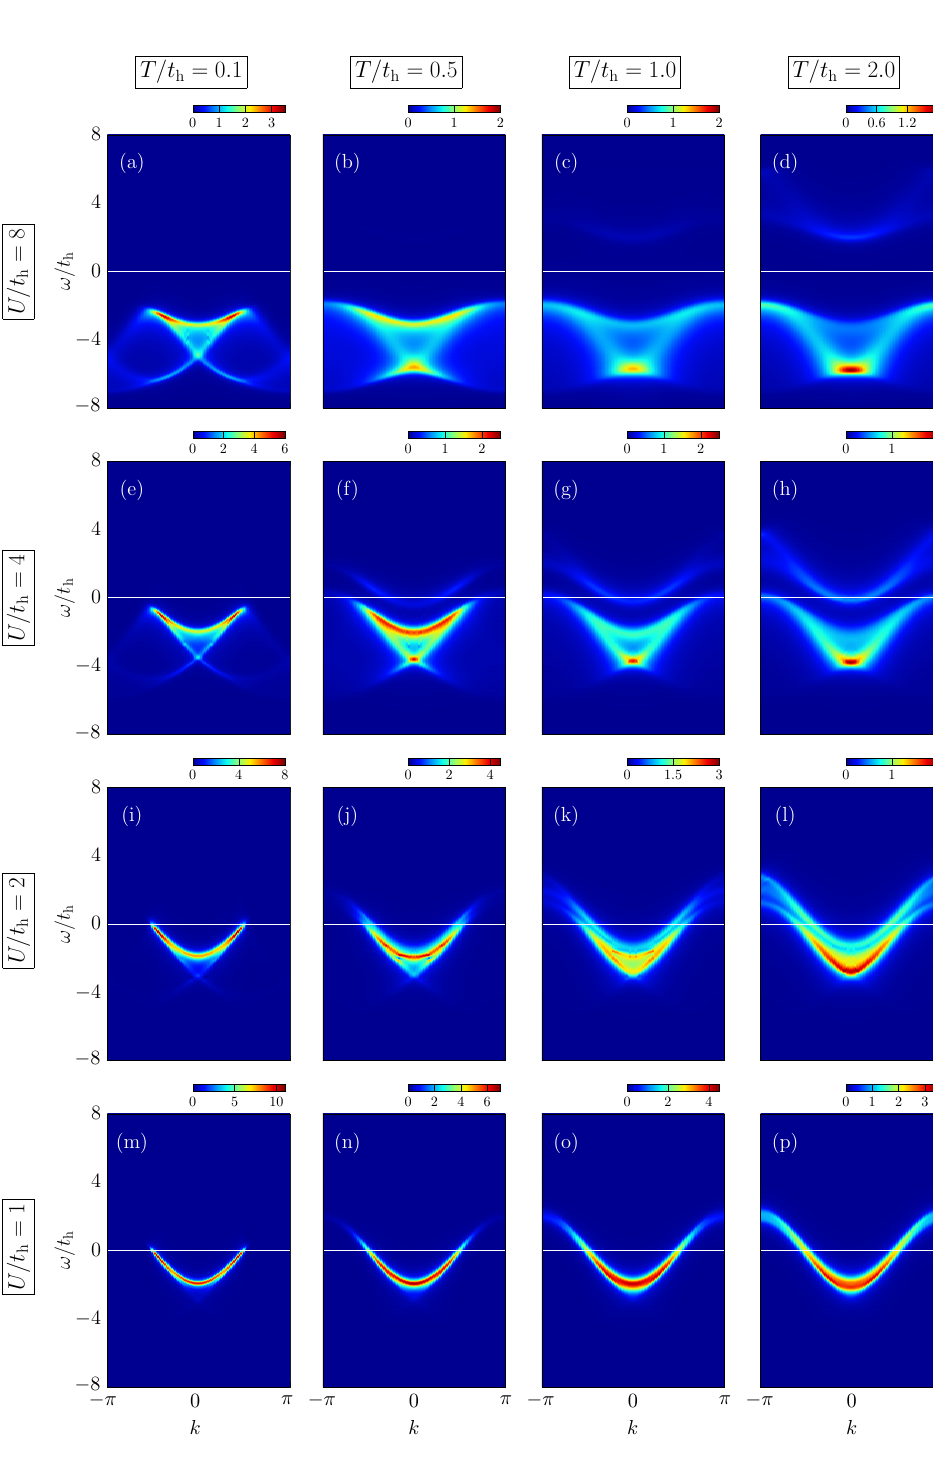
at different temperatures T / t h h